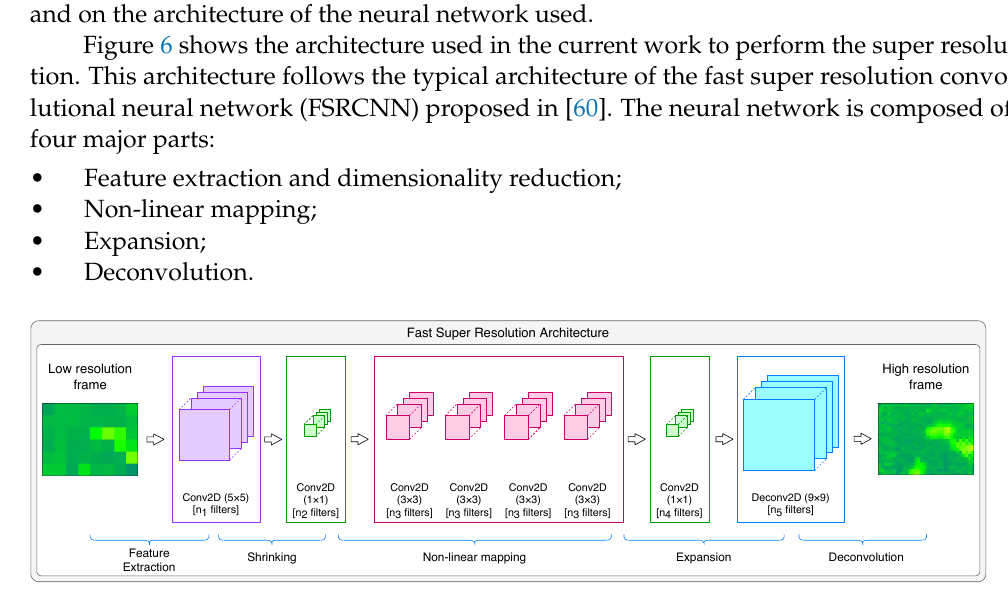
Figure 6. The architecture of the neural network used to generate high-resolution